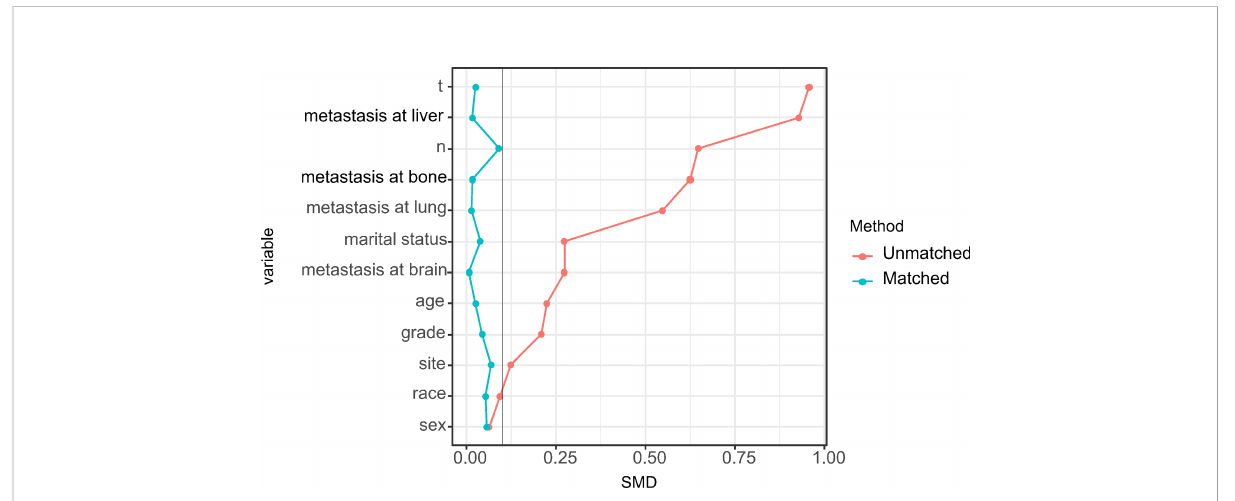
FIGURE 2 Distribution of standardized mean differences (SMDs) between the surgical and nonsurgical treatment modalities before and after propensity score